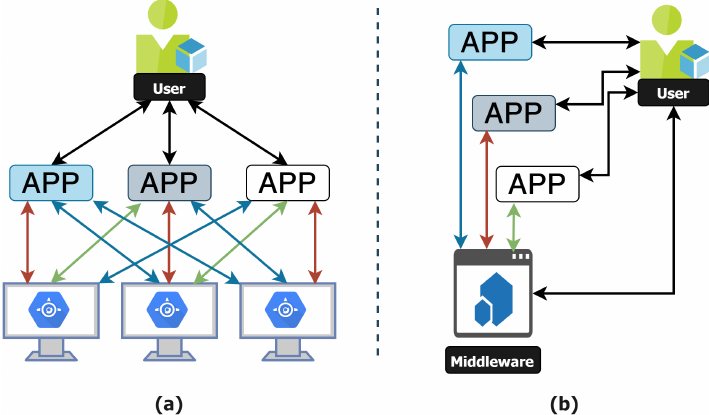
Figure 9. ( a ) Illustration of user data flow without middleware. ( b ) Illustration of middleware integrated IoT network responsible for handling data flow between users and multiple